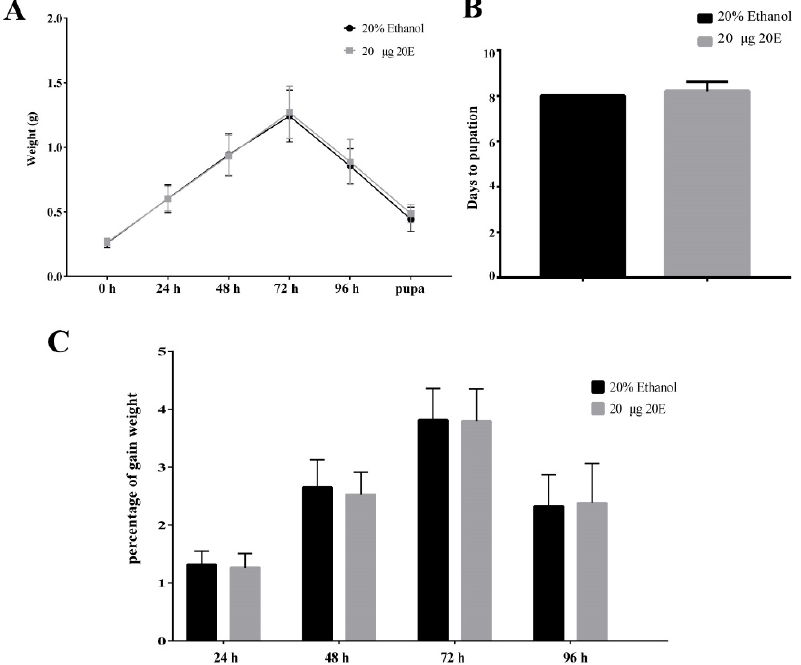
Figure 1. Effects of the ingested 20E (20 µ g/larva) on the growth and development of the S. litura larvae. ( A ) The average weight of the larvae treated with 20E or 20% ethanol. ( B ) The time to pupation of the larvae after 20E or 20% ethanol treatment. ( C ) Percentage of the gain weight of the larvae treated with 20E or 20% ethanol.